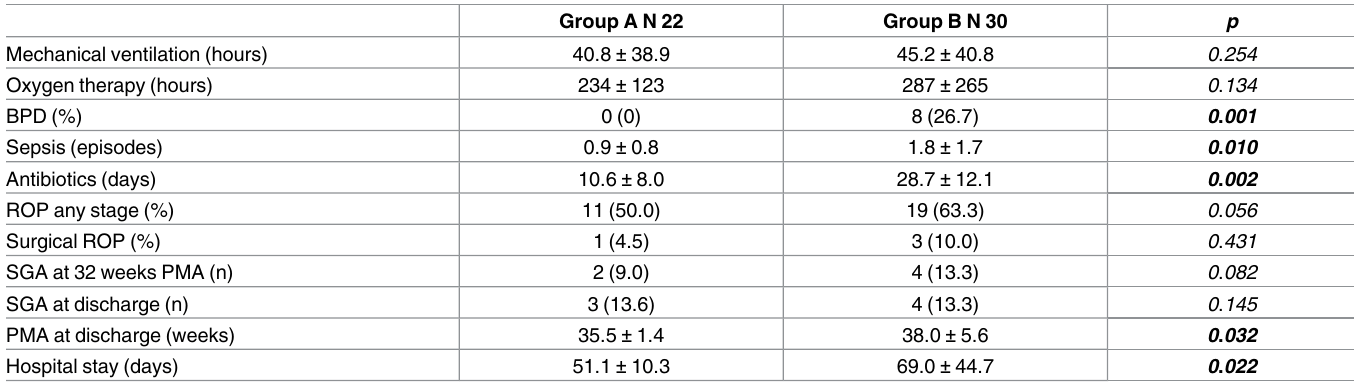
Table 3. Clinical